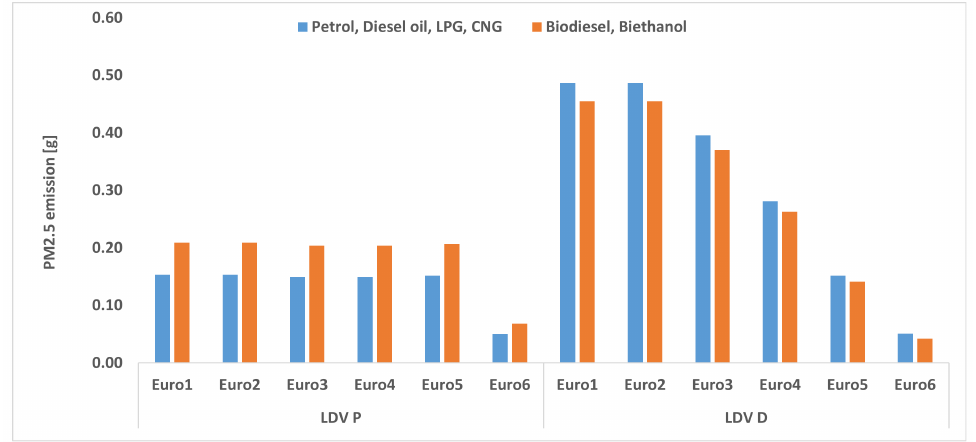
Figure 13. Comparison of PM2.5 emissions from LDVs depending on Euro standard and fuel